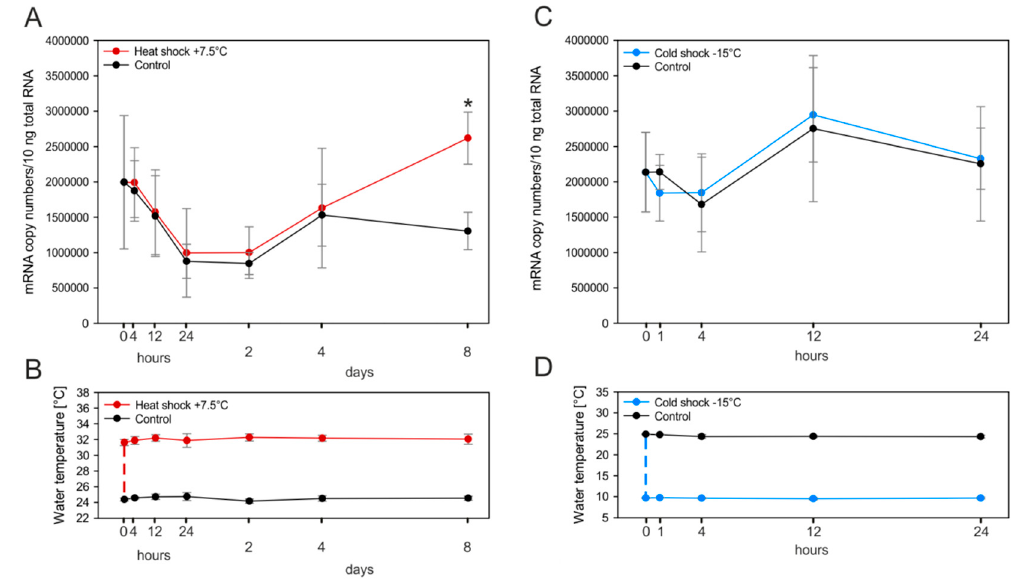
Figure 6. ( A ) MT induction and pattern in the midgut gland of Biomphalaria glabrata in untreated individuals (black line) and snails exposed to a sudden temperature increase (+7.5 ◦ C) (red line), persisting through a period of 8 days. Means and standard deviations are shown ( n = 4). The course of MT mRNA transcription levels was tested by two-way ANOVA ( p ≤ 0.05) but was insignificant. The star indicates a significant difference at a single time point according to multiple t -test comparisons; ( B ) water temperature profile for the duration of exposure. The dotted line indicates the heat shock at day 0; ( C ) MT induction pattern in the midgut gland of Biomphalaria glabrata in untreated individuals (black line) and animals exposed to a sudden temperature decrease ( − 15 ◦ C) (blue line), through a period of 24 h. Means and standard deviations are shown ( n = 4). The course of MT mRNA transcription levels was tested by two-way ANOVA ( p ≤ 0.05) but was insignificant. ( D ) water temperature profile for the duration of exposure. The dotted line indicates the cold shock at day